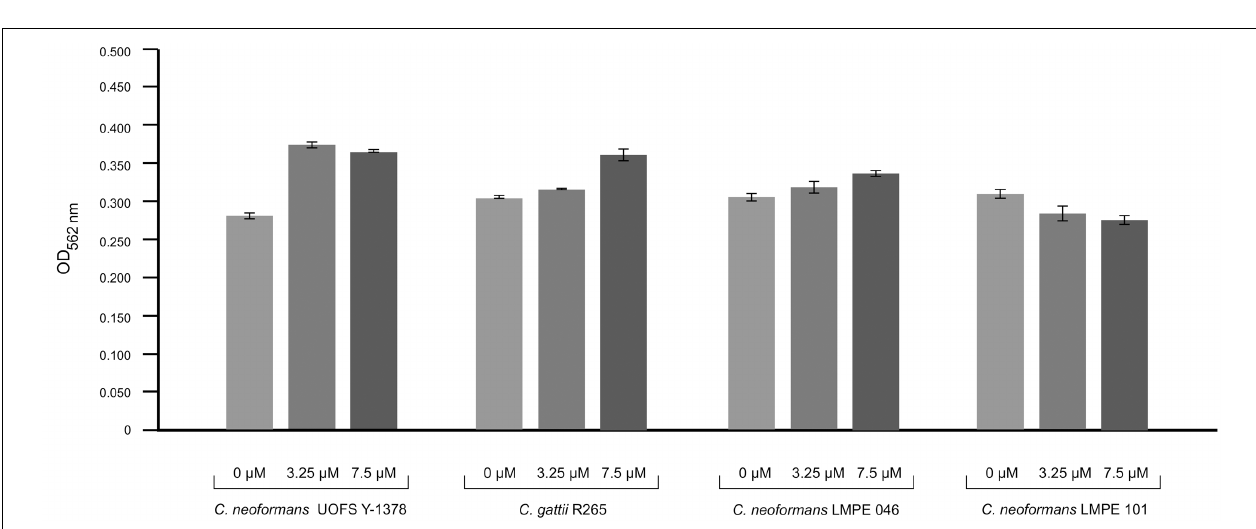
FIGURE 4 | Results of the effect of amoebapore on the growth of different cryptococcal strains i.e., C. neoformans UOFS Y-1378 (has 3-hydroxy C9:0), C. gattii R265 (has no 3-hydroxy C9:0), C. neoformans LMPE 046 (has 3-hydroxy C9:0), and C. neoformans LMPE 101 (is acapsular and has no 3-hydroxy C9:0). When considering the growth results, it is evident that the strain with 3-hydroxy C9:0 was much more resistant to the effects of amoebapore when compared to the other three strains that do not have 3-hydroxy